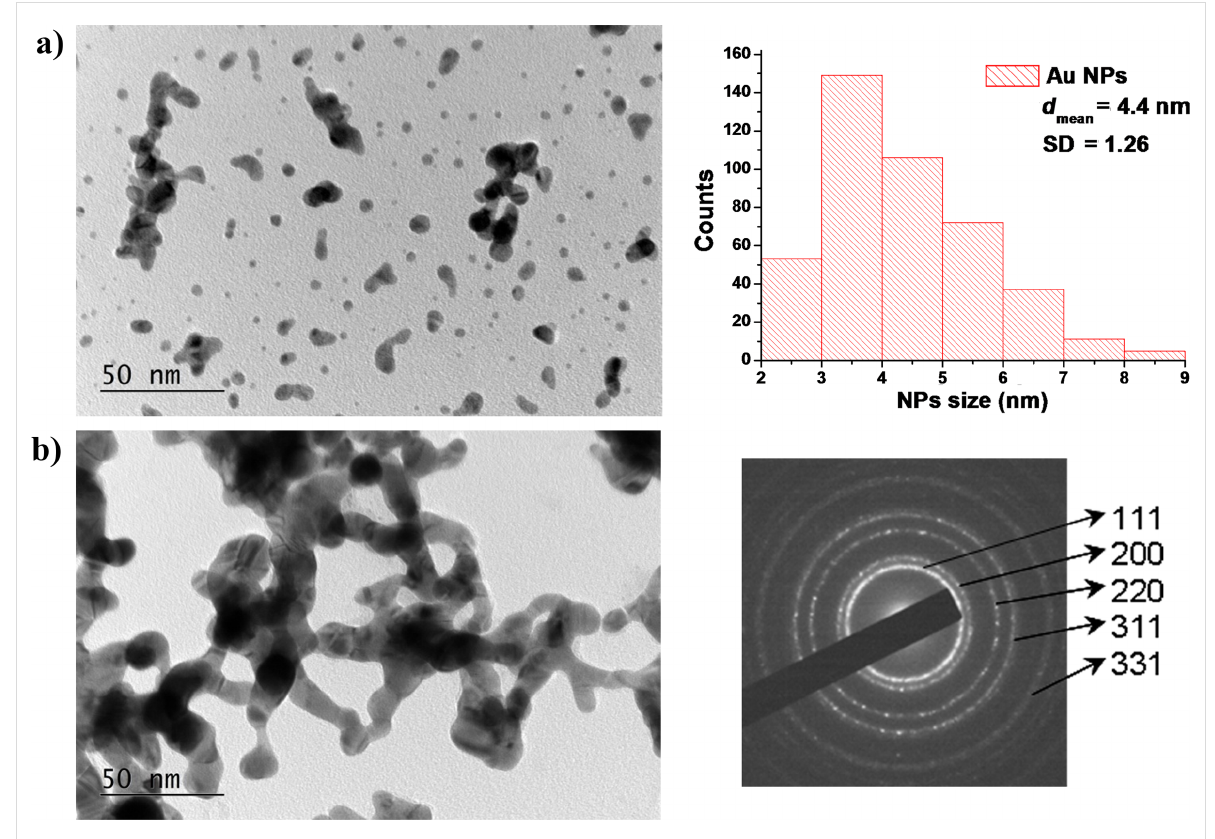
Figure 1: (a) TEM image of the material ablated in open air and the size distribution of the nanoparticles produced using 600 laser pulses. (b) TEM and SAED images of the Au sample deposited using 1800 laser pulses on a quartz substrate and transferred to a TEM grid. The samples were deposited in a standard on-axis configuration (geometry 4).